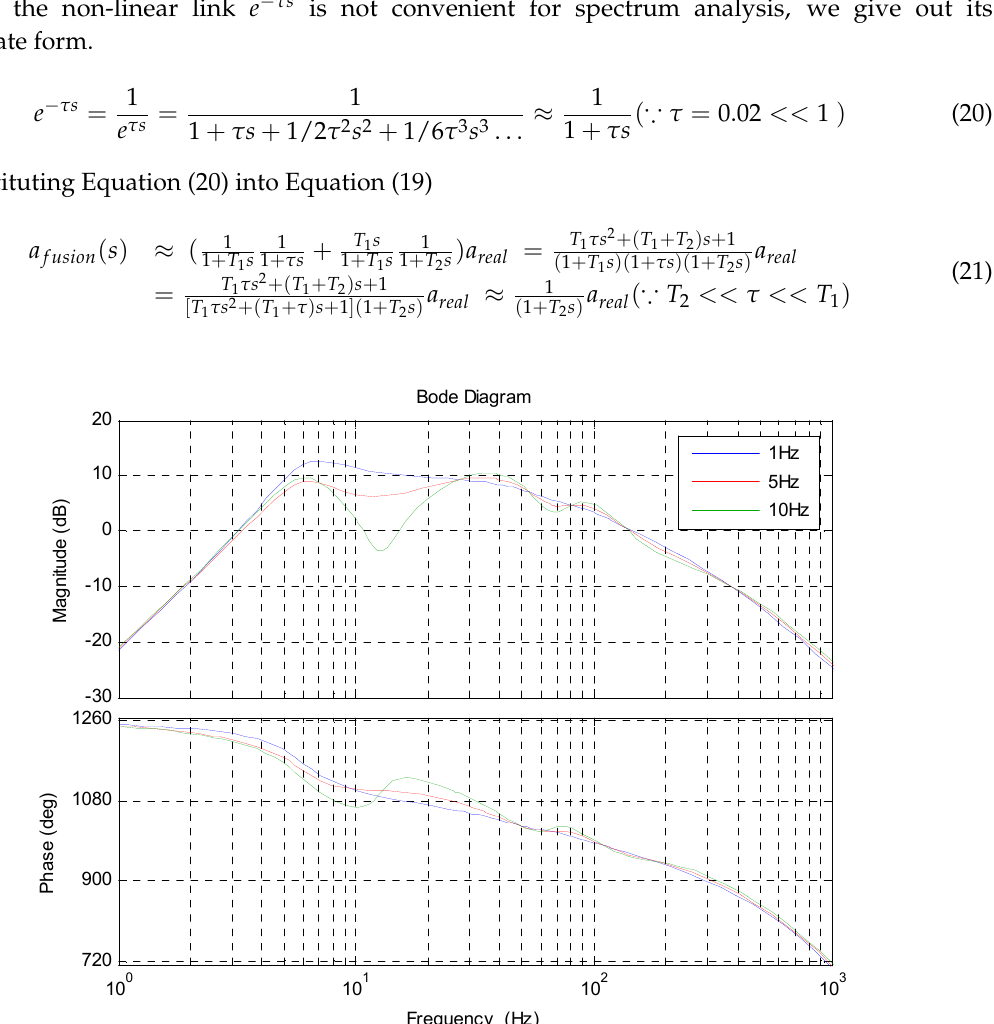
Figure 5. The simulation of the acceleration bode response with different 1/ T 1